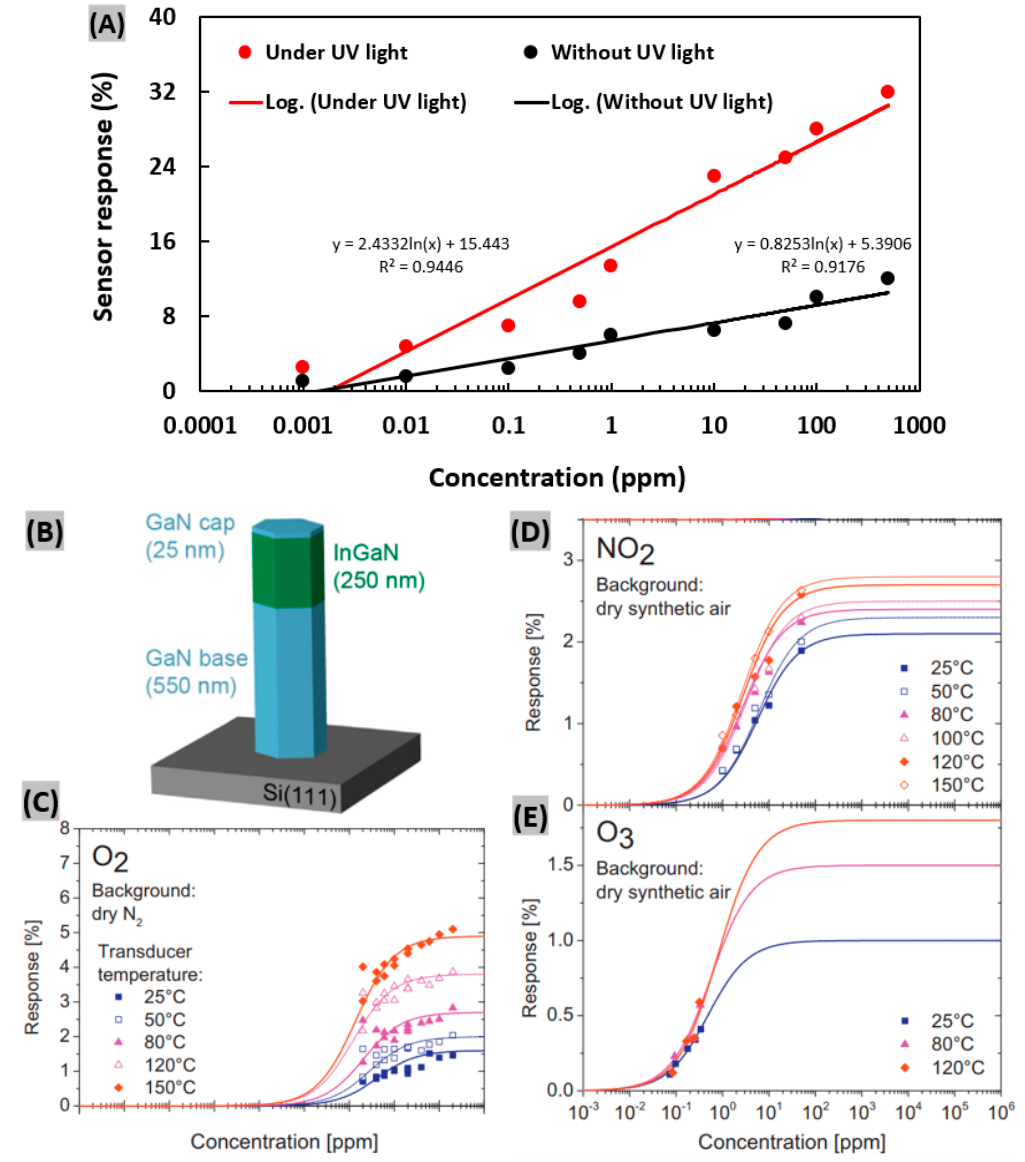
Figure 4. ( A ) Response fitting curves of the of GaN / TiO 2 NW sensor to NO 2 concentrations ranging from 1 ppb to 500 ppm with UV light and without UV light at room temperature (20 º C). Figure adapted with permission from [59], Copyright 2020 IOP Publishing Ltd. ( B ) Schematic representation of the GaN/InGaN NW on Si substrate. Variation of ( C ) O 2 -response, ( D ) NO 2 -response, and ( E ) O 3 -response for GaN/InGaN NW sensor with gas concentration and operating temperature. Figures adapted with permission from [61], Copyright 2014 Elsevier.